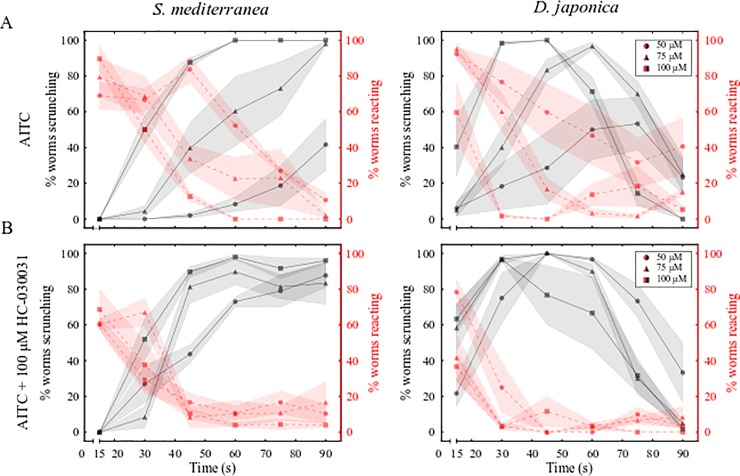
HC-030031 decreases scrunching latency induced by AITC.(A, B) Behavior scoring plots for S. mediterranea (left) and D. japonica (right) showing the percentage of worms scrunching (black lines) or reacting (behaviors other than scrunching, see Methods; red lines) every 15 s over 90 s when exposed to (A) AITC or (B) AITC + 100 μM HC-030031. Markers and shading represent the mean and standard deviation of 3 technical replicates, respectively.